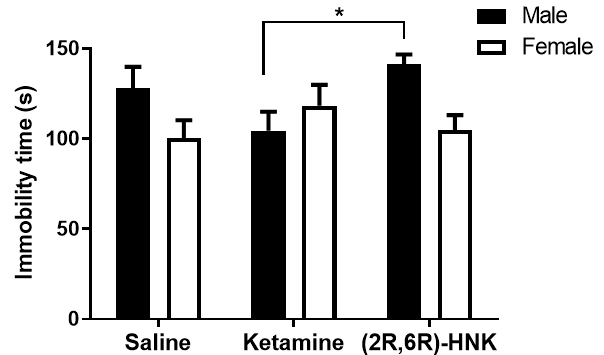
Figure 2. E ff ects on the i mmobility time measured in the forced swim test (FST) 24 h after a single injection with ketamine or (2R,6R)-HNK in Arc-CreER T2 × CAG-Sun1 / sfGFP mice. (Two-way ANOVA: interaction: F(2,80) = 3.397, p = 0.0384; sex: F(1,80) = 3.924, p = 0.0510; n = 11–18 mice per group). Bonferroni post test showed that male mice treated with ketamine are more immobile than those treated with (2R,6R)-HNK [ t = 2.89 df = 80, * p < 0.05]. Immobility time is presented in mean (s), error bars represent ± SEM.